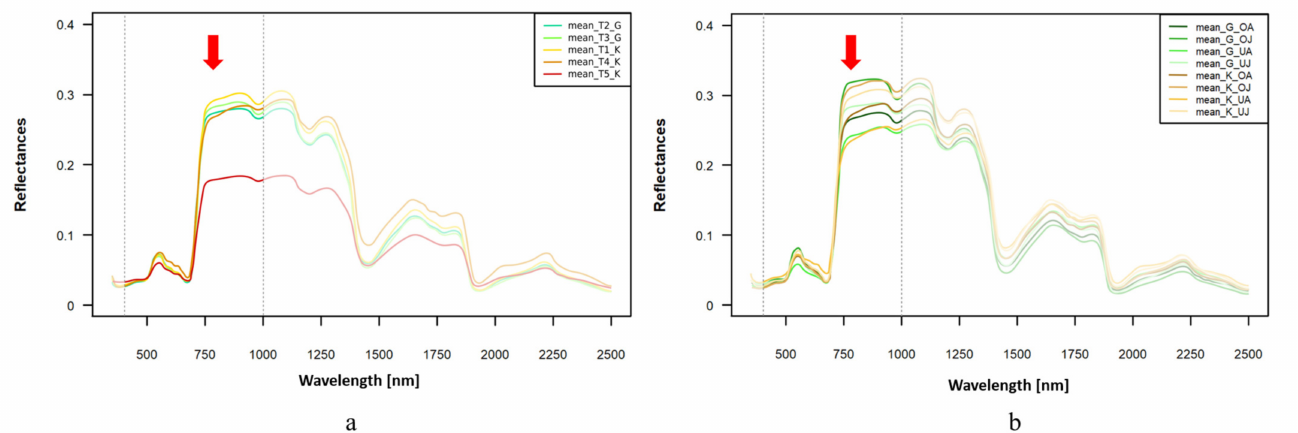
Figure 7. ( a ) Reflectance spectra of all investigated trees, averaged above all positions (OA, OJ, UA, UJ); ( b ) averaged reflectance spectra of healthy (G, green colors, T2 and T3) and infested (K, yellow colors, T1 and T4) trees depending on their position (OA, OJ, UA and UJ). The red arrows show the wavelength domain where the main differences between healthy and infested trees can be detected. The wavelength range λ = 400–1000 nm is highlighted, as it corresponds to the range that is common with the airborne HySpex data. The comparison of the mean absolute reflectance factors of the needles of healthy trees (mean_G) and those in the green attack phase (mean_K) reveals differences in the red-edge range (marked with a red